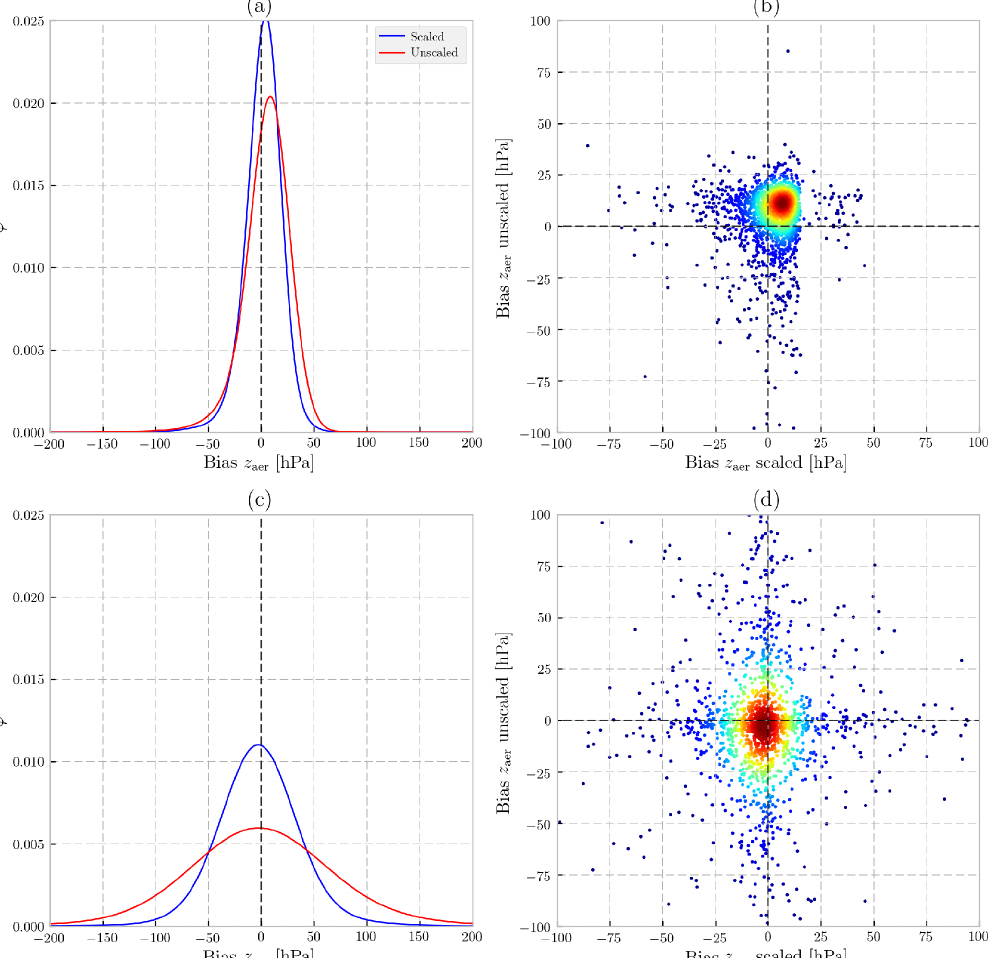
Figure 2. Biases in retrieved z aer (in hPa) from synthetic measurements (2000 in total for each experiment) discussed in Sect. 4. The top row represents z aer biases in the presence of a model error in the thickness of the aerosol layer. The bottom row represents z aer biases in the presence of a model error in A s . (a, c) Probability distribution function ϕ of retrieval biases. Blue line represents results from the dynamic scaling method, and the red line represents those for the formal approach. (b, d) 2-D density plot showing the distribution of biases (density ranges from high in red to low in blue). The x axis represents biases from the dynamic scaling method, whereas the y axis represents biases from the formal